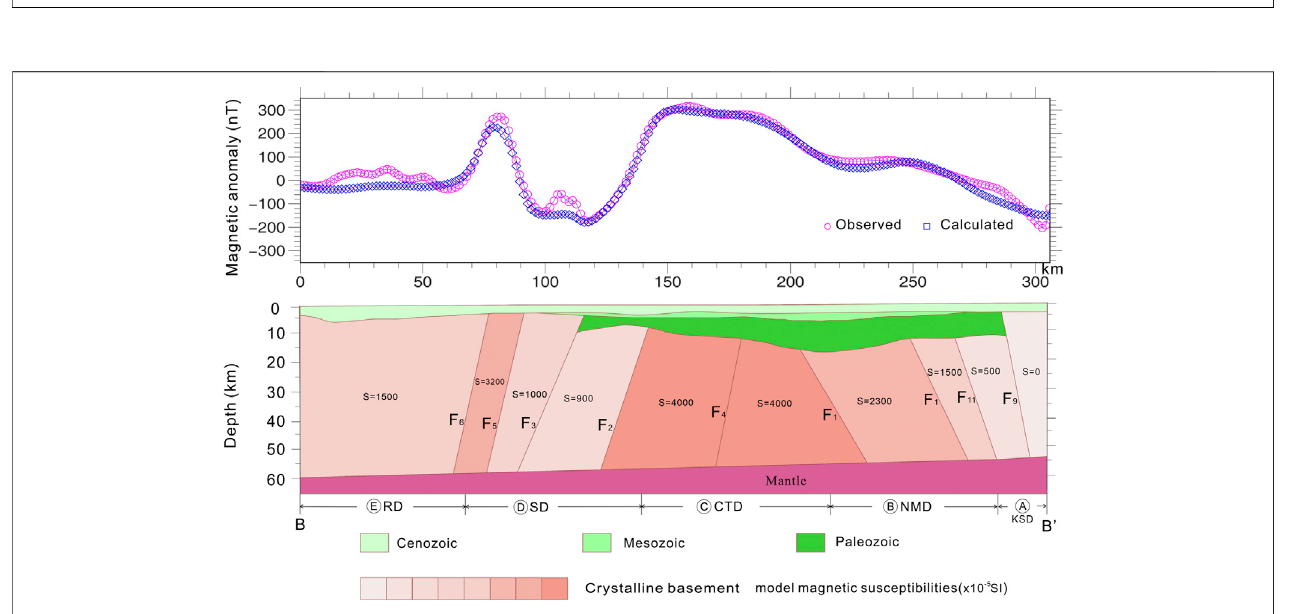
FIGURE 8 | Pro fi le BB ′ for magnetic forward modeling, pro fi le location showed in Figure 3A . See Figure 7 for other fi gure descriptions.